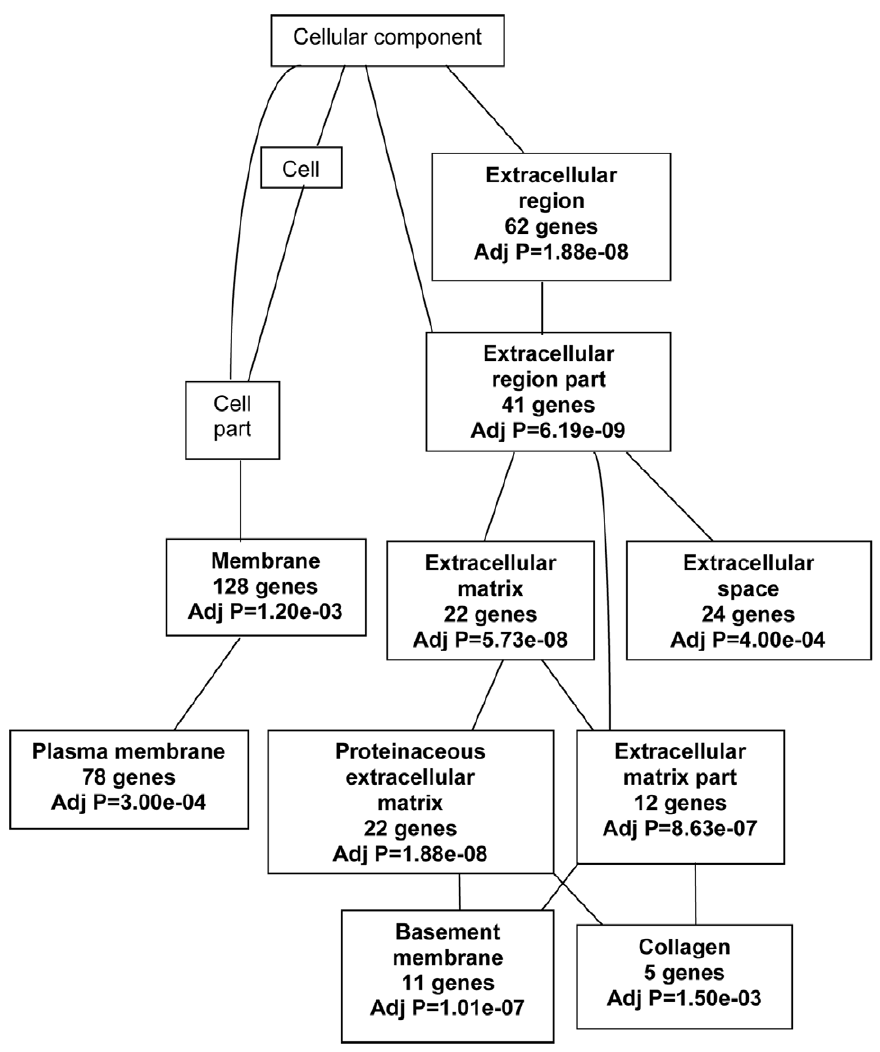
Figure 3. Cellular components related to significantly differentially expressed genes. The differentially expressed genes in all models of DCIS in comparison to MCF10A were analyzed by WebGestalt2 tool. The p -values and the number of differentially expressed genes associated with a particular cellular component are indicated in bold in the respective boxes.